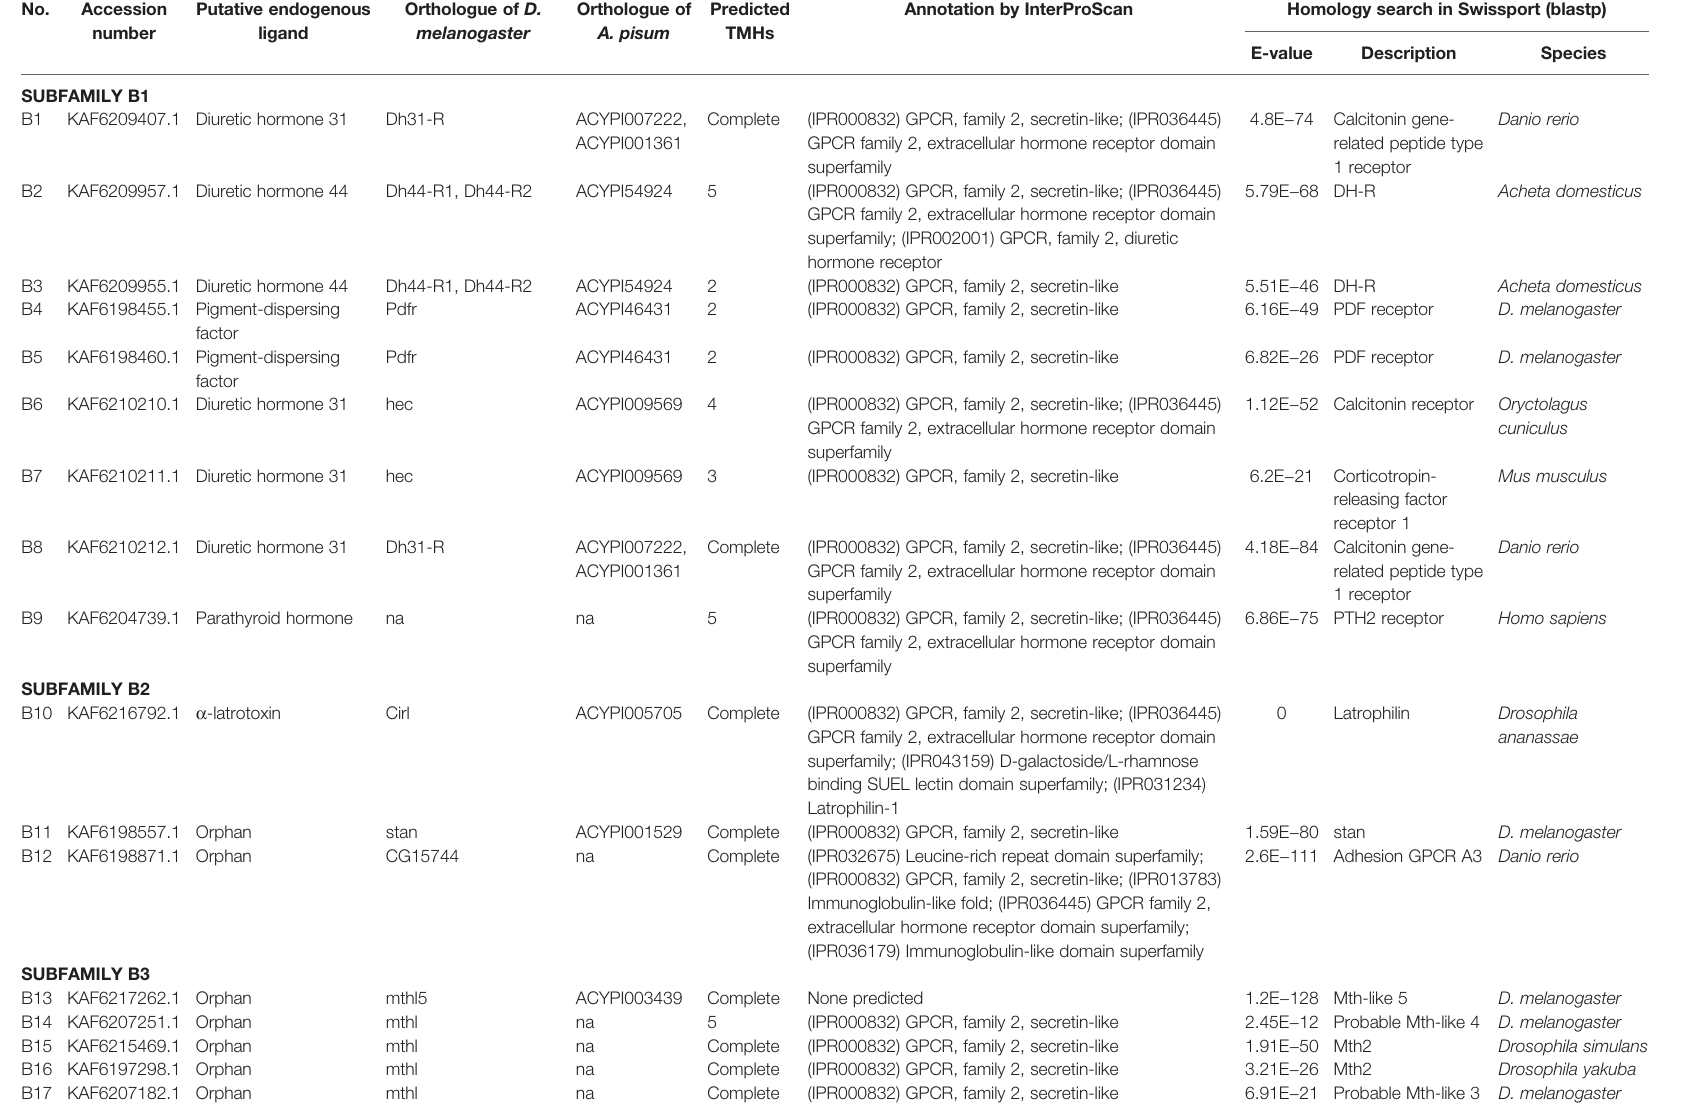
TABLE 3 | Family-B GPCRs of A. lucorum